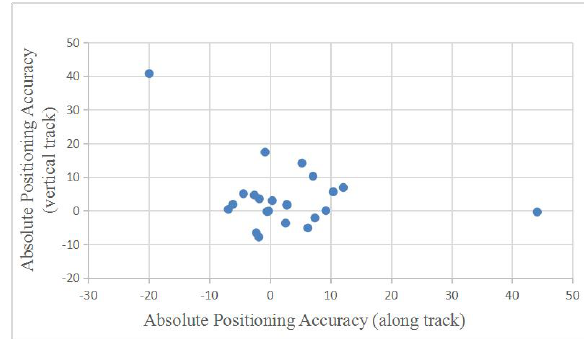
Figure 5. Spatial distribution of absolute positioning accuracy in GE’s